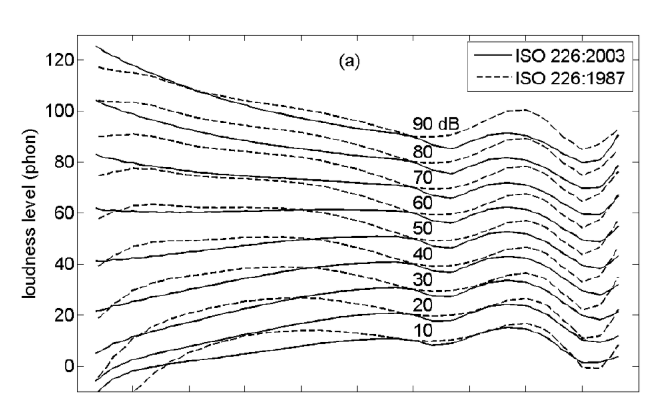
Figure 2. Contours of equal A-weighted sound level as a function of frequency and loudness level, according to ISO 226:2003 and ISO 226:1987 (a) and according to ISO 226:2003 and ANSI S3.4-2007 (b)